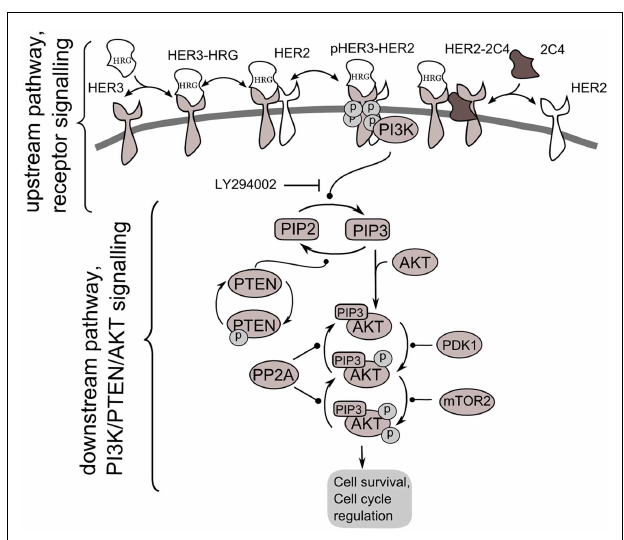
FIGURE 2 | Scheme of PI3K/PTEN/AKT signaling network activated by heterodimerization of HER2/HER3 receptors induced by heregulin (HRG) and inhibited by pertuzumab, 2C4 . Decomposition of the signaling network to upstream pathway (receptor signaling pathway) and down-stream pathway (PI3K/PTEN/AKT network) is